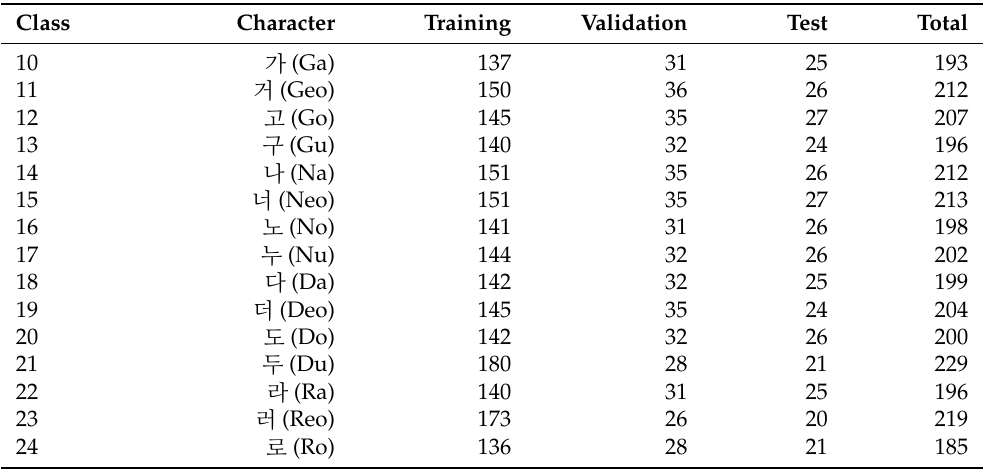
Table 4. Collected data for Korean LP characters; classes 55, 57, 60, 61, 63, 64, and 67 were not sufficiently collected (highlighted in